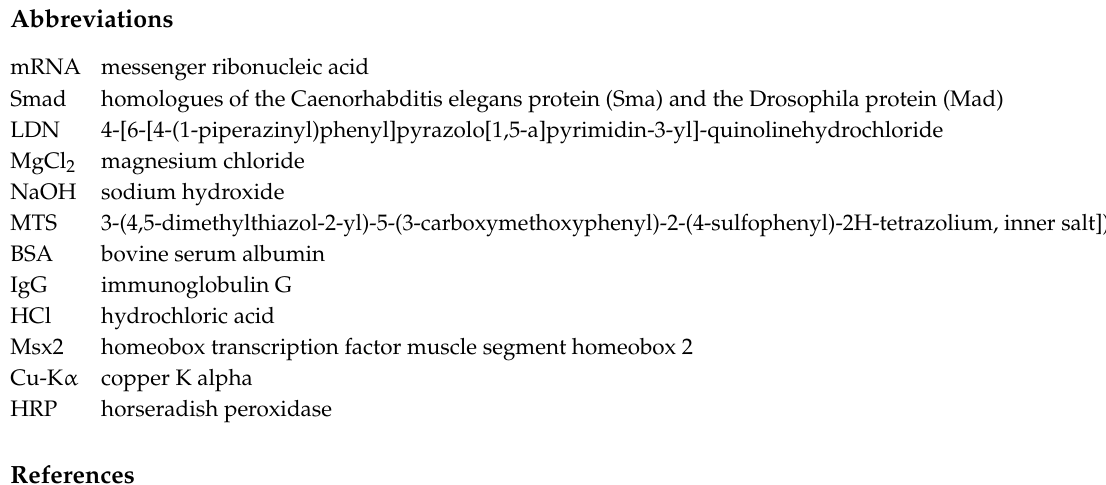
Figure S1: Combined e ff ect of MDZ and BMP-2 on ALP activity in the C2C12 cells; Figure S2: Ideal XRD patterns for DCPD, OCP, and HAP; Figure S3: HR-TEM and FFT images of nanofibers; Table S1: Selected primers, size of amplified product for qPCR analysis shown in main Figure